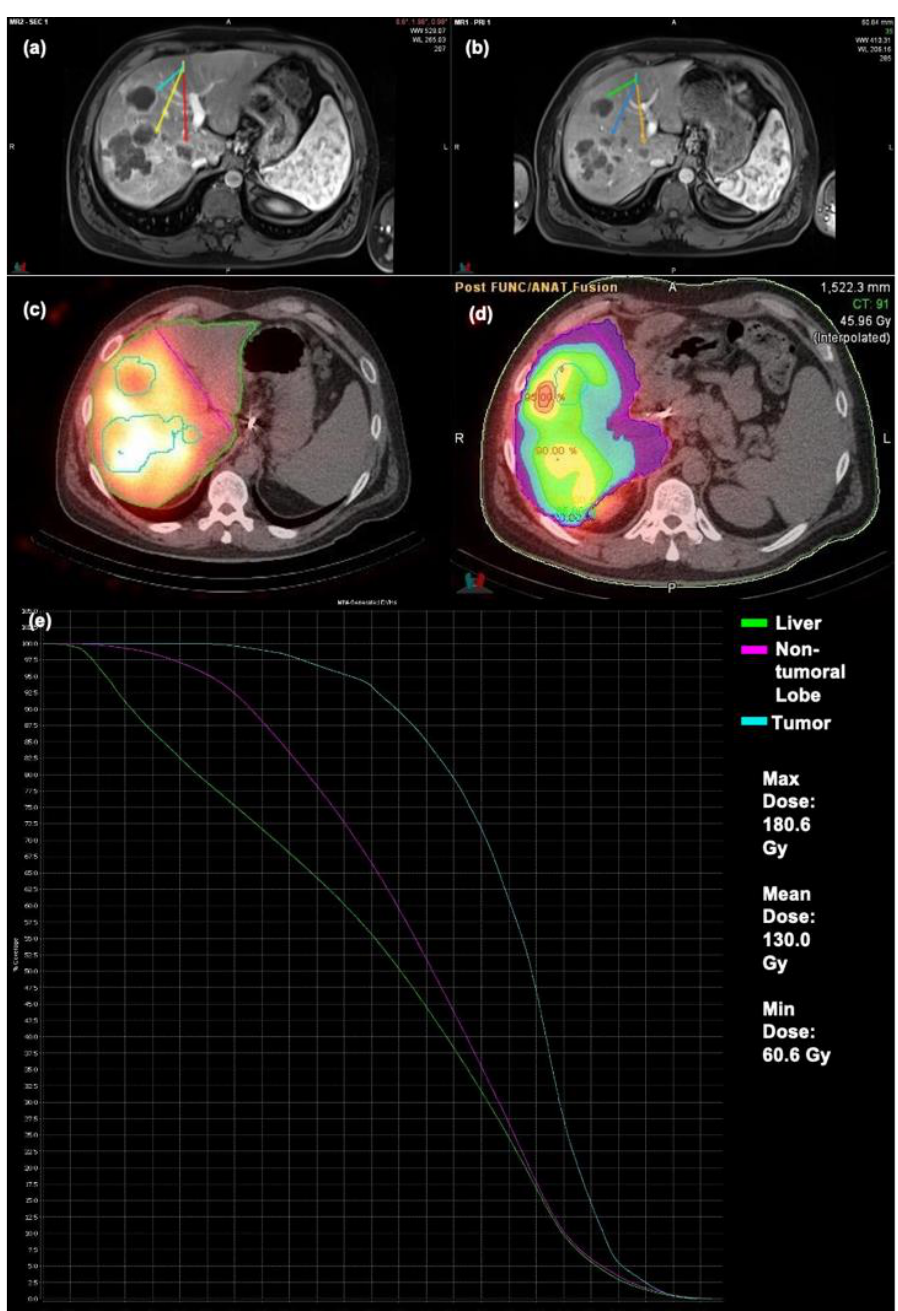
Figure 4. Patient exhibiting OR to Y90 therapy ( a ) Pre-op MRI ( b ) Post-op MRI ( c ) Bremsstrahlung SPECT/CT ( d ) Dosimetry map ( e ) DVH Curve.